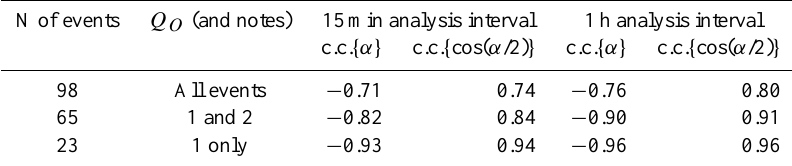
Table 1. Linear correlation coefficients for α and cos( α /2) vs. | CA | .